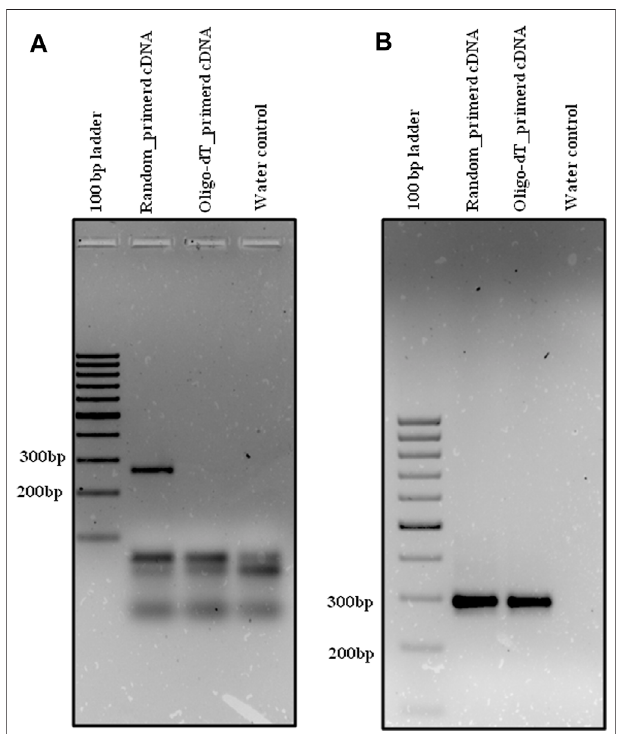
FIGURE 5 | Divergent PCR in rice. Divergent PCR using (A) osi_DC_02 yielded ~218 bp amplicon with random-primed cDNA but not with oligo-dT- derived cDNA, whereas convergent PCR using (B) os_ β -actin yielded ~126 bp amplicon with both random-primed cDNA and oligo-dT- derived cDNA. Generuler 100 bp ladder was loaded as a